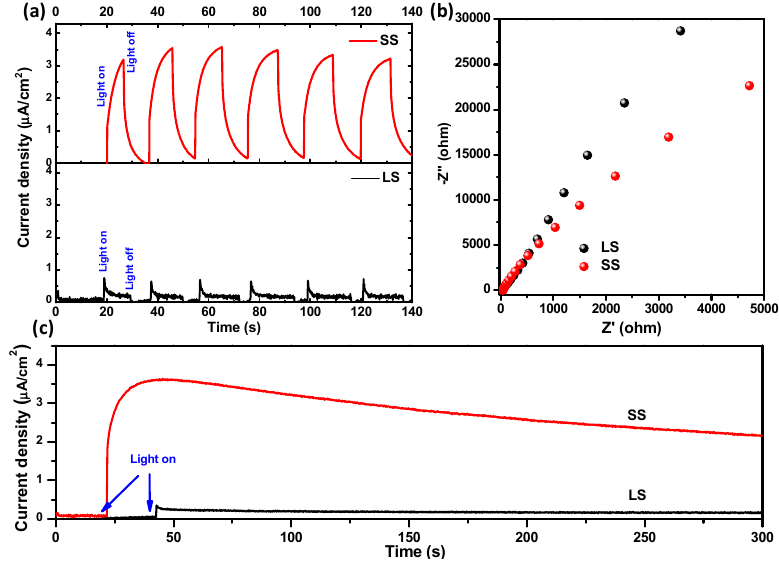
Figure 7. Photoelectrochemical properties of the SS and LS SnO 2 samples: ( a ) photoresponse; ( b ) electrochemical impedance (EIS; Nyquist plots) of the electrodes measured under visible light irradiation; and ( c ) change in the current density with time ( I–t curves) recorded under visible light illumination.